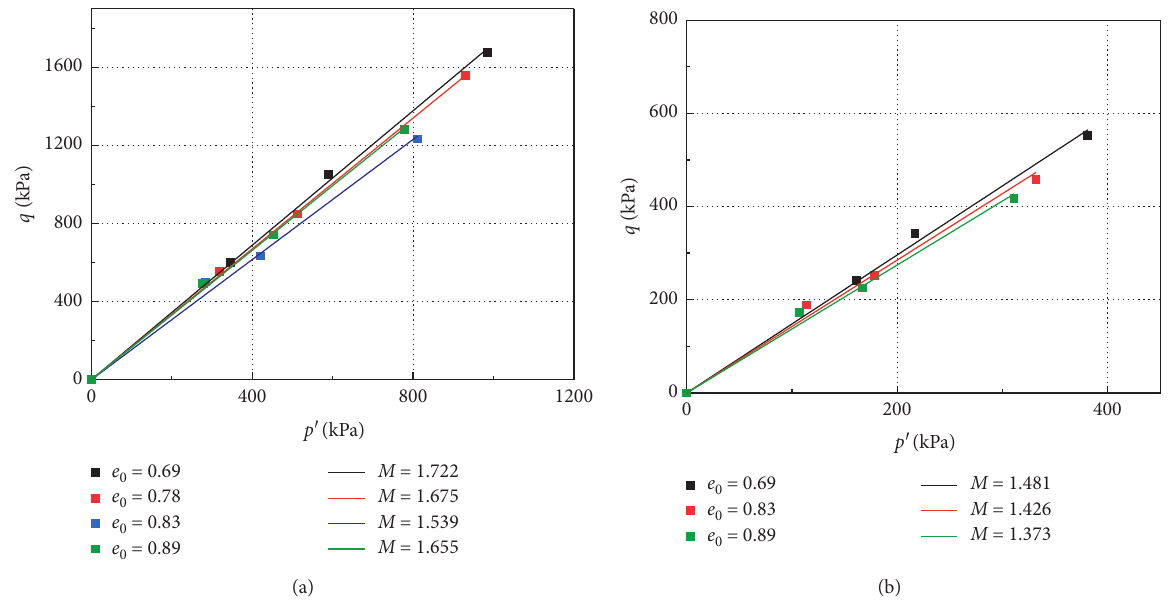
Figure 12: M cs with different initial void ratios: (a) coral mud and (b) Taizhou